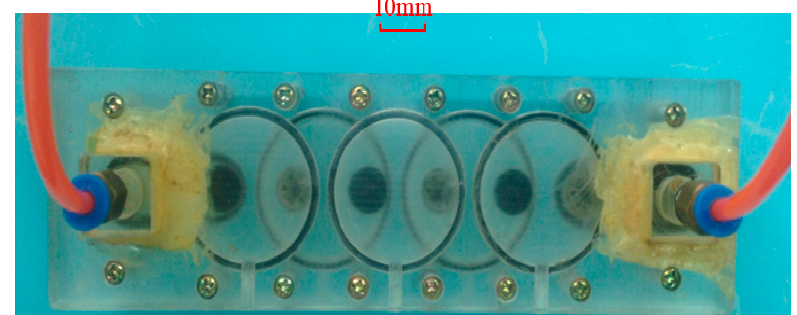
Figure 3. The prototype photograph of the single-active-chamber piezoelectric membrane pump with multiple passive check valves.